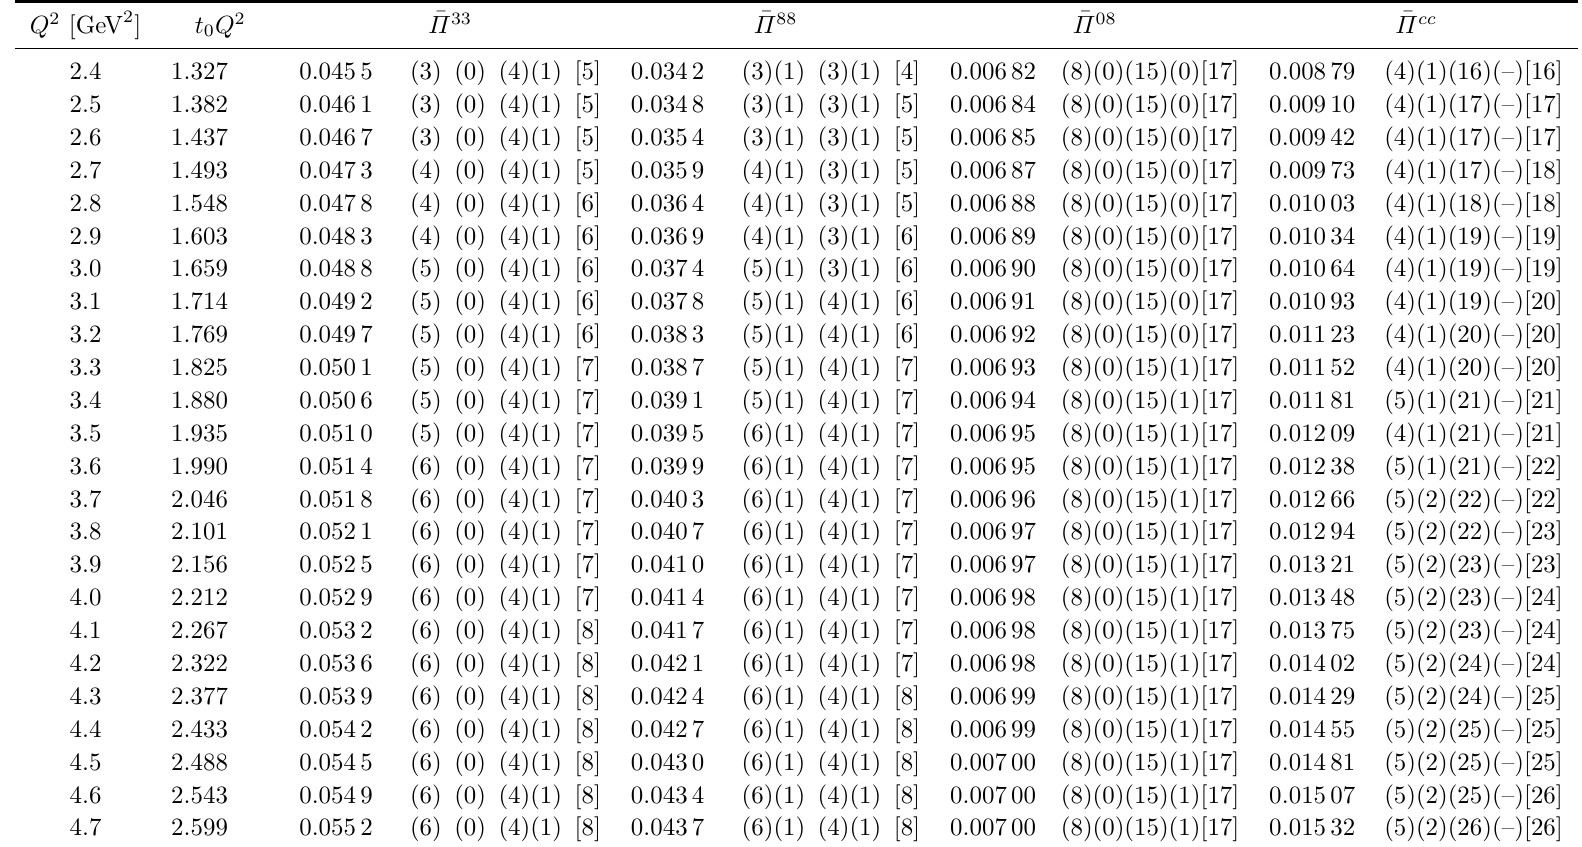
Table 12 . Results for the ¯ Π 33 , ¯ Π 88 , ¯ Π 08 and ¯ Π cc HVP contribution extrapolated to the physical point for all the values of Q 2 sampled. The first quoted uncertainty is the statistical error, the second is the systematic error from varying the fit model estimated in section 4.1.1, the third is the scale-setting error (see section 4.2.1), and the fourth is the systematic from missing charm sea-quark loops (see section 4.2.2). The final uncertainty, quoted in square brackets, is the combination of the previous ones